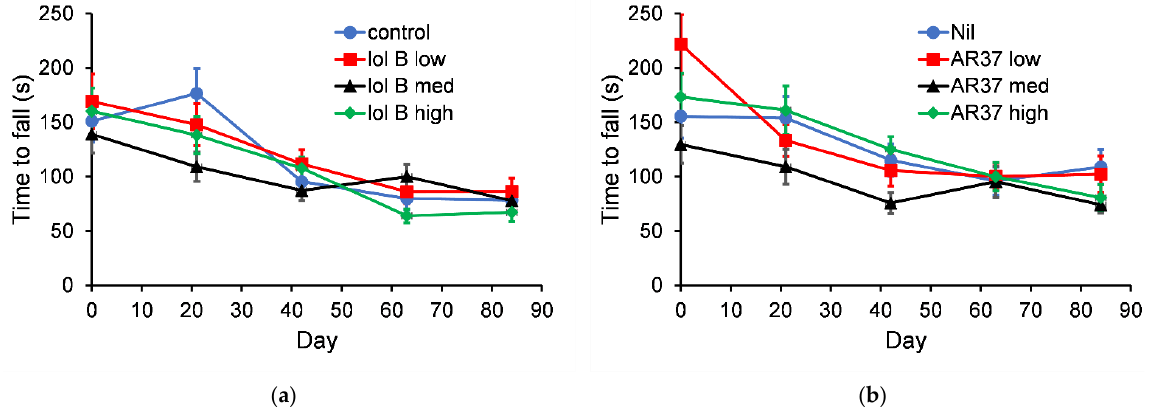
Figure 3. Temporal trend in motor coordination (time to fall) of mice fed ( a ) lolitrem B (0, 0.265, 0.53 or 1.06 ppm for control, low, med and high, respectively) or ( b ) AR37 endophyte-infected seed (0, 7.5, 15 or 30% for nil, low, med and high, respectively). The error bars are the standard error obtained from the fitted model.